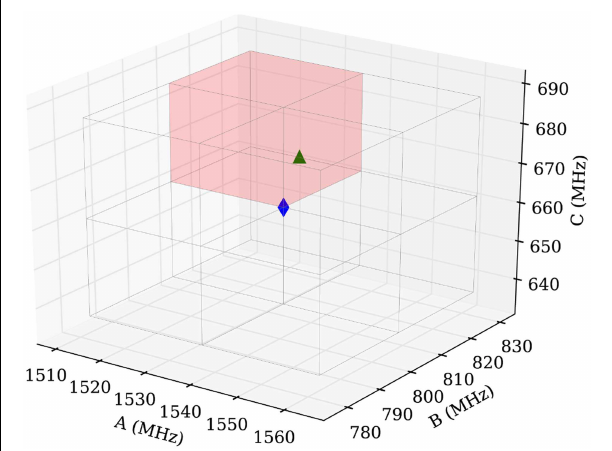
FIGURE 9 | Scheme of the sampling volume of the rotational constants for the computer aided assignment routine. The cubic sampling volume is divided into eight subcubes and the routine is carried out consecutively in each of the subcubes. Afterwards the results of the individual subcubes are compared. The blue diamond in the center indicates the position of the calculated rotational constants and the green triangle indicates the position of the experimentally obtained value for isomenthone eq-ax A. The red shaded area is used to display the results in Figure 10 .